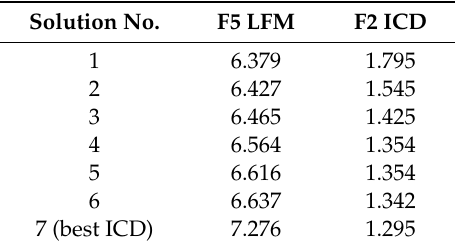
. Figure 8. The Pareto frontier for the pair F1–F5.